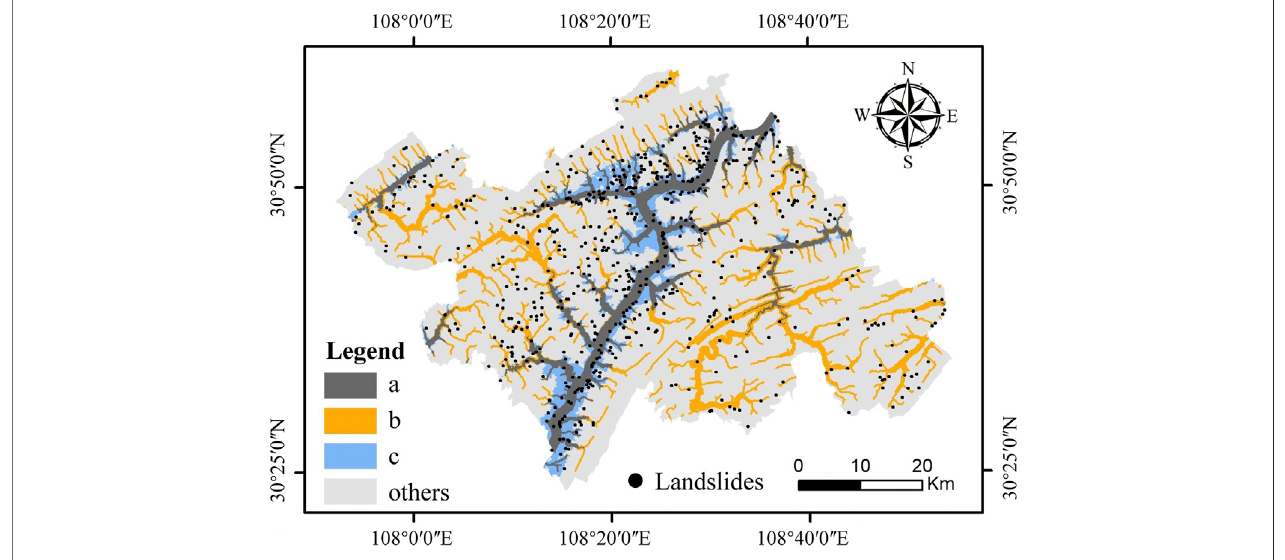
FIGURE 3 | Spatial distribution of altitude-class-1 and rivers-class-1.